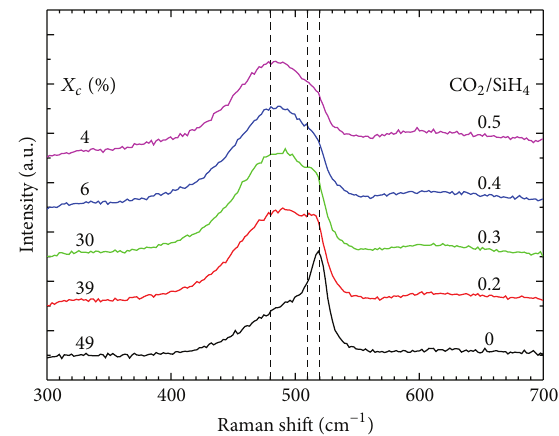
Figure 4: Dependence of the crystalline volume fraction on the CO 2 /SiH 4 ratio for p- 𝜇 c-Si 1−𝑥 O 𝑥 :H